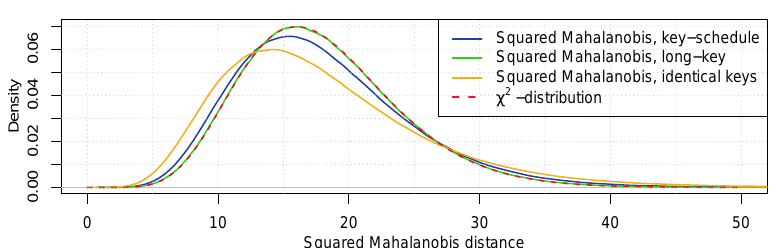
Figure 1: The densities of the squared Mahalanobis distance of the joint correlation distribution for 18 approximations over 9 rounds of 32-bit SmallPresent for three different key-schedules. The plot show a connection between dependence between the round keys, and how much the correlation distribution deviates from joint